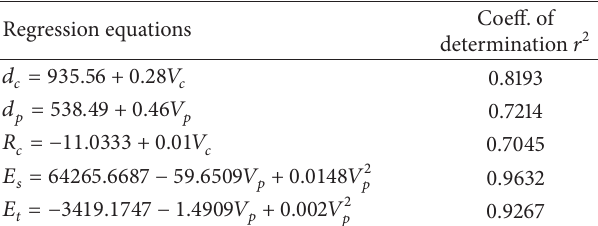
Table 5: Regression equations and coefficient of determination 𝑟 2 of 𝑉 to physical and mechanical